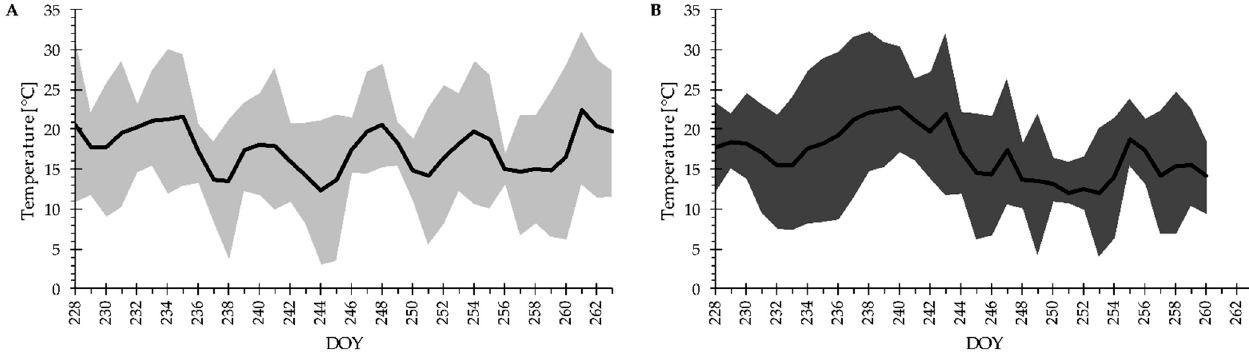
Figure 2. Mean daily temperature (°C) in 2018 ( A ) and 2019 ( B ). Shaded area indicates minimum and maximum tempera- tures. Complete data are available via the Supplementary Materials (Table S1).